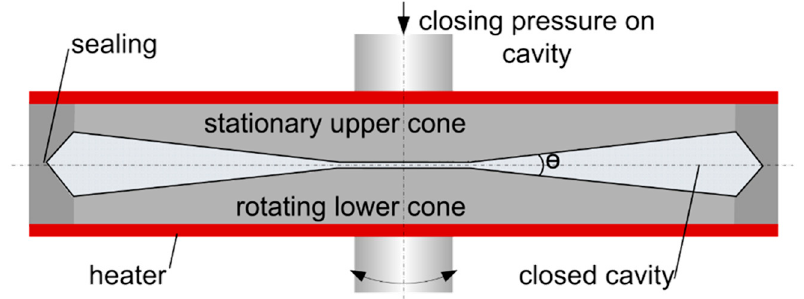
Figure 1. Closed cavity rheometer used for rheological characterisation of the material (picture taken from Emin and Schuchmann, 2017 [42]).